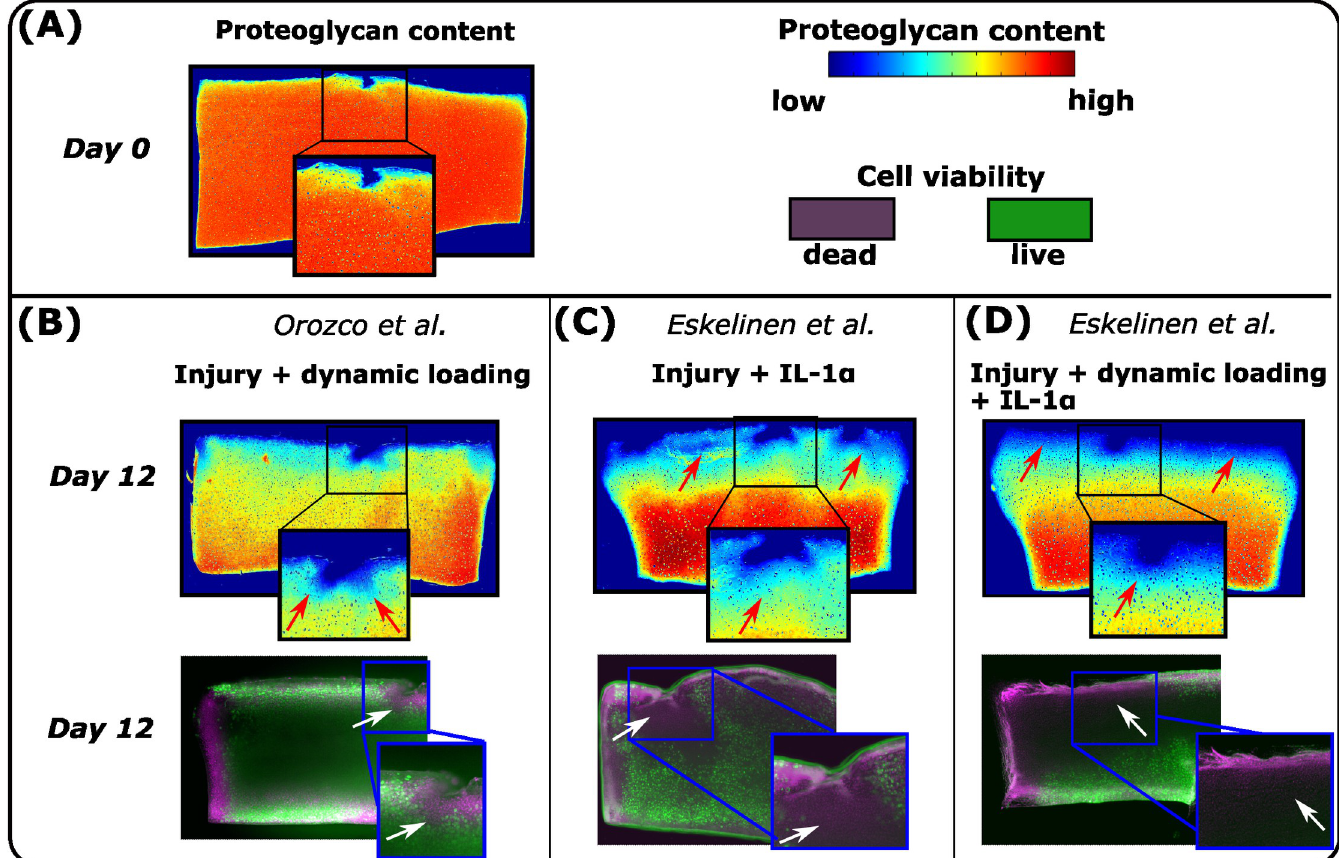
Fig 2. Previous experiments. In the previous experiments conducted by Orozco et al. [17] and Eskelinen et al. [40], the injured, dynamically loaded, and IL- 1-challenged cartilage samples were analyzed at several time points during 12-day cultures. Cell viability and optical density (an estimate of proteoglycan (PG) content) were measured with fluorescence microscopy and digital densitometry, respectively. (A) At day 0, PG loss in cartilage was minor. At day 12, the results showed (B) substantial cell death and PG loss near lesions after dynamic loading in the injured cartilage. IL-1 challenge induced cell death and PG loss also in the intact areas (C) without and (D) with dynamic loading post-injury. Red arrows highlight locally low optical density and white arrows locally high cell death.